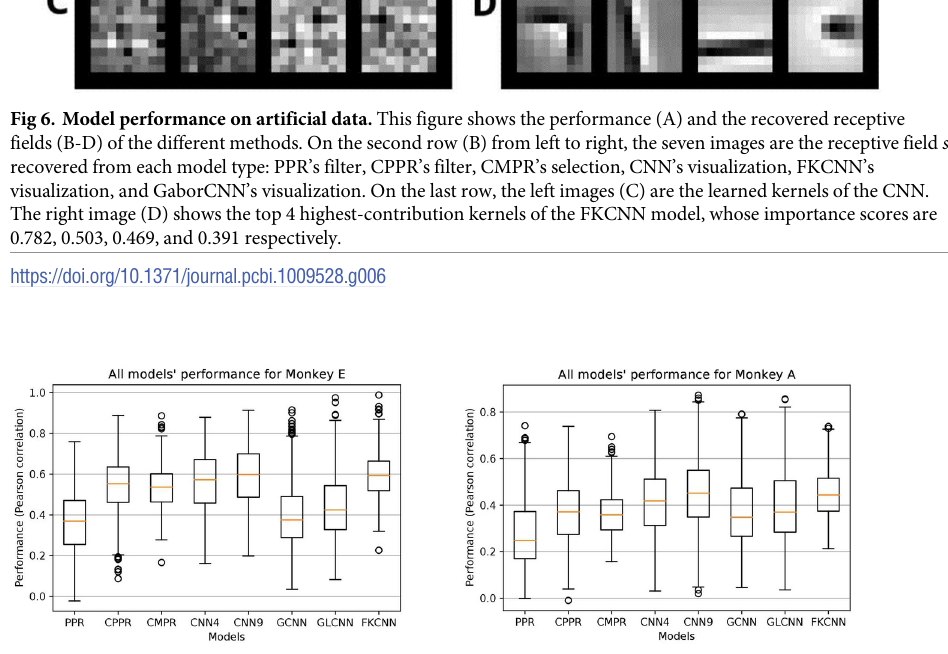
Fig 7. Model performance on neuronal data. Box-plots of response prediction performance based the Pearson correlation between true and predicted responses of all modeled neurons. The performance of all models on Monkey A is shown on the left and performance on Monkey B is shown on the right. Overall, the performance is significantly better for Monkey E because of higher-quality neuronal recordings for this monkey.